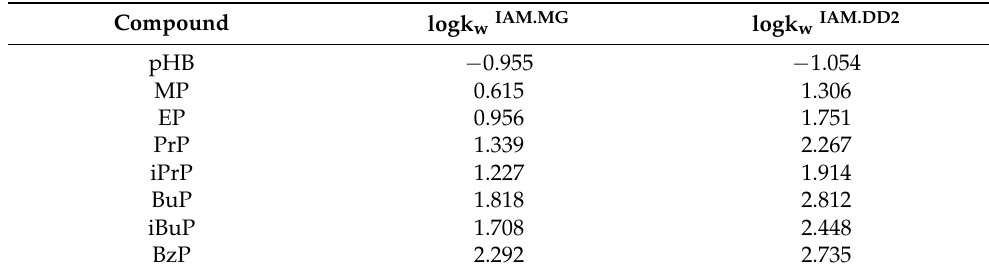
Table 3. Experimental phospholipophilicity values measured on both the IAM.PC.MG and IAM.PC.DD2 stationary phases.